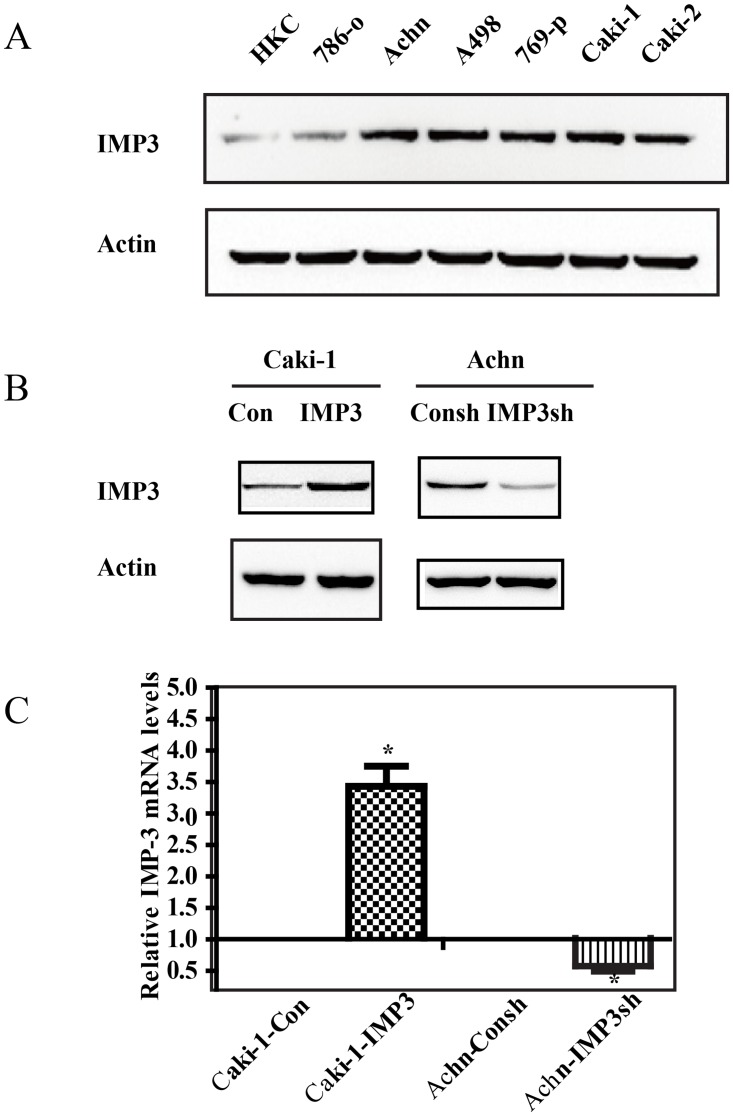
Establishment of stable cell lines with IMP3 overexpression or knockdown.Expression of IMP3 in a panel of RCC cell lines and normal HKC cells by Western blot analysis (A). Stable overexpression of IMP3 in Caki-1 cells (left panel) transfected with FLAG-IMP3 vector and knockdown of IMP3 in Achn cells (right panel) by ShRNA (B). Real time-qPCR was performed to detect the relative mRNA expression of IMP3 in IMP3 overexpression or knockdown cells (C). Values shown are mean ± SEM of three independent experiments. * p< 0.05 vs. control group.